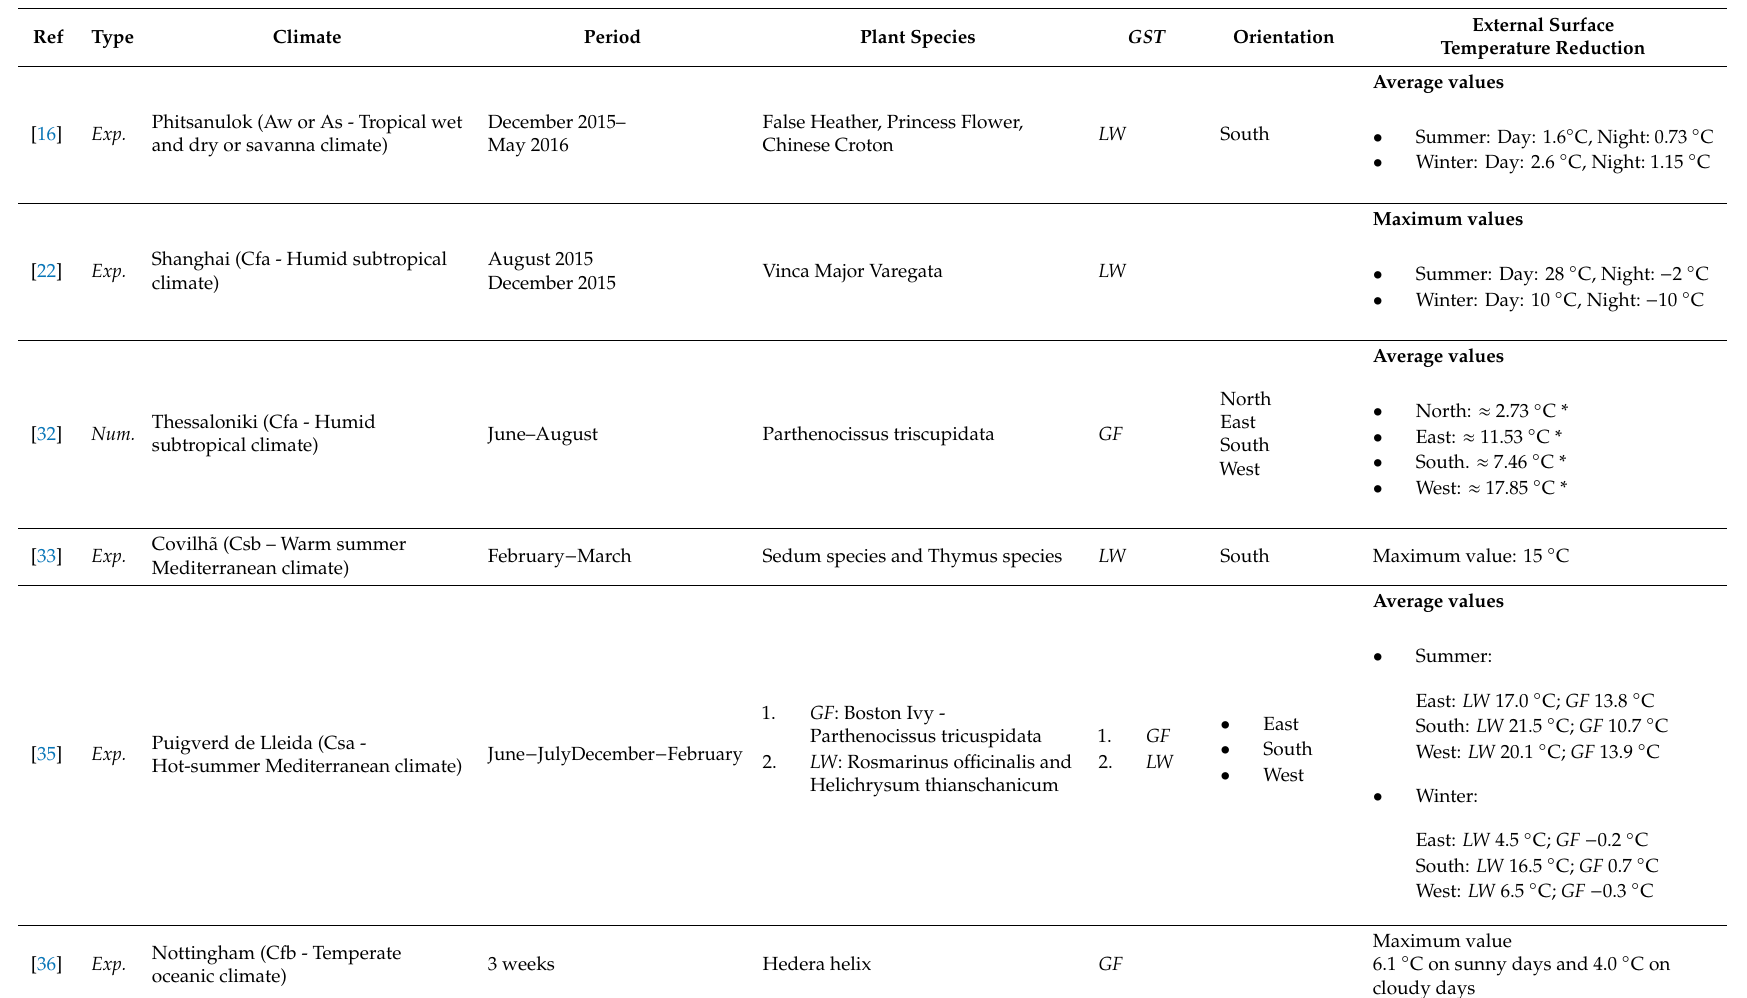
Table 3. Results about surface temperature reduction (please, note that GF is Green Façade, LW is Living Wall, N stands for configuration, 1. and 2. are used when two di ff erent GST are